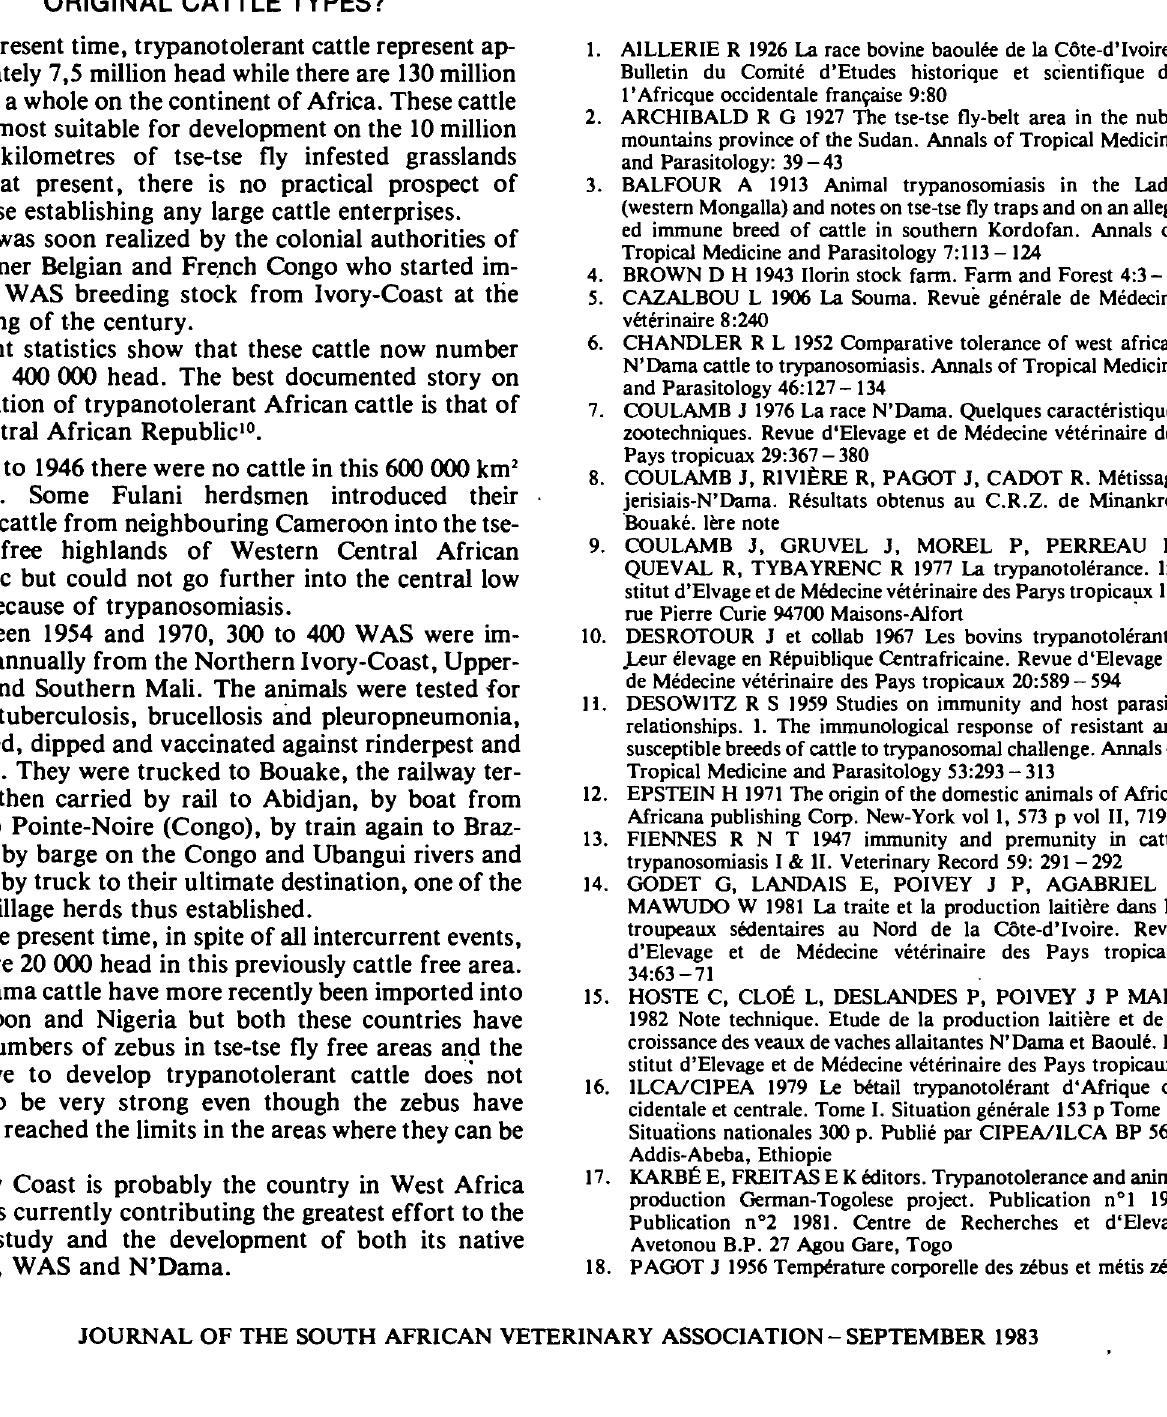
1. AILLERIE R 1926 La race bovine baoulee de Ia Cote-d'lvoire. Bulletin du Comite d'Etudes historique et scientifique de I' Africque occidentale fran~aise 9:80 2. ARCHIBALD R G 1927 The tse-tse fly-belt area in the nuba mountains province of the Sudan. Annals of Tropical Medicine and Parasitology: 39 -